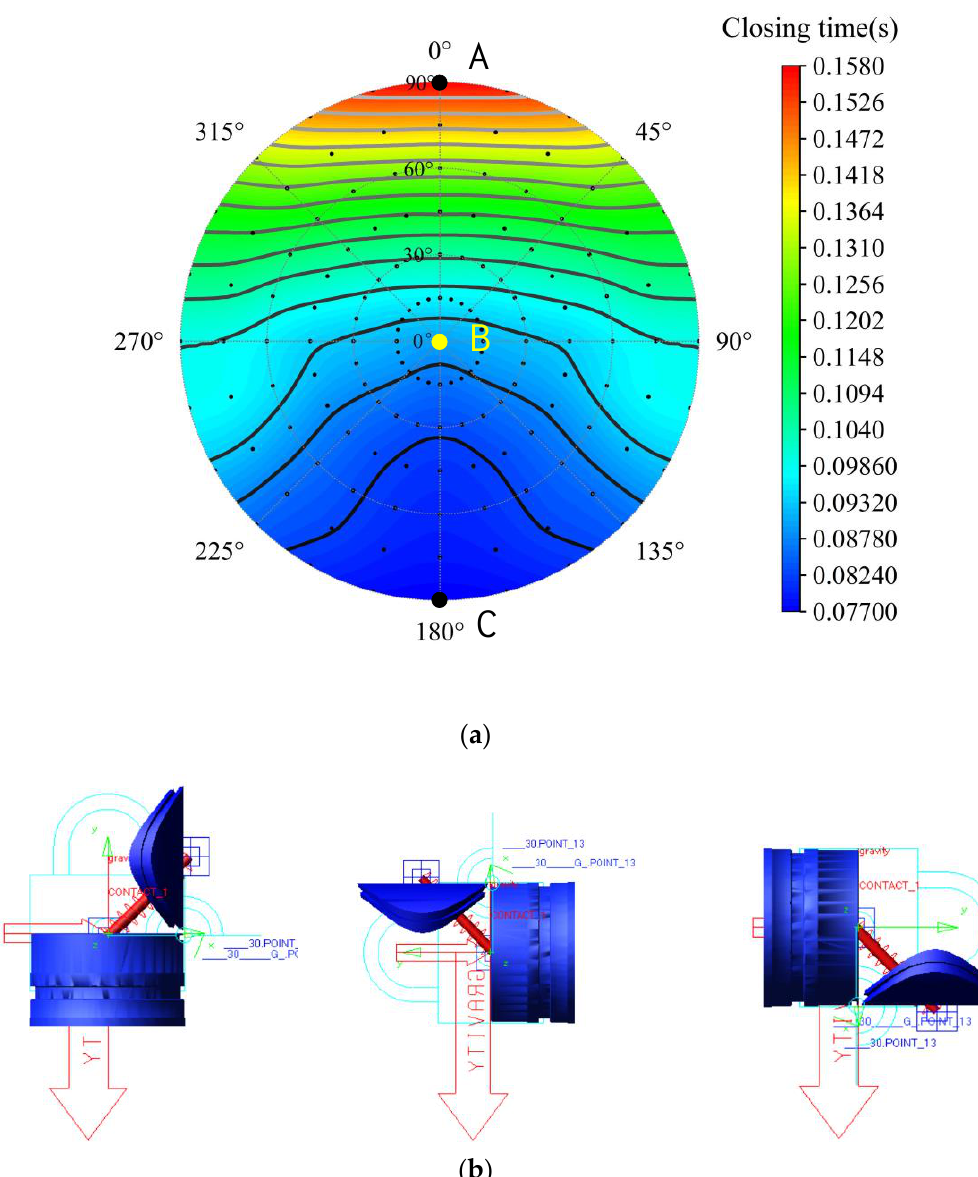
Figure 8. ( a ) Distribution law of valve cover closing time for pressure-holding controller under different azimuth deflection angles. ( b ) Closing simulation model of pressure-holding controller at three typical azimuth angles of A, B, and C (Figure 6a).